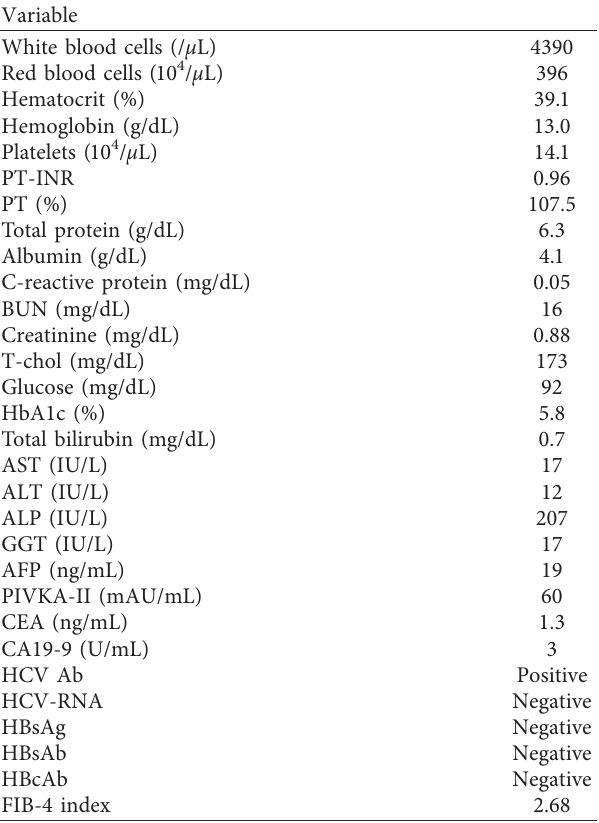
Table 1: Laboratory findings on